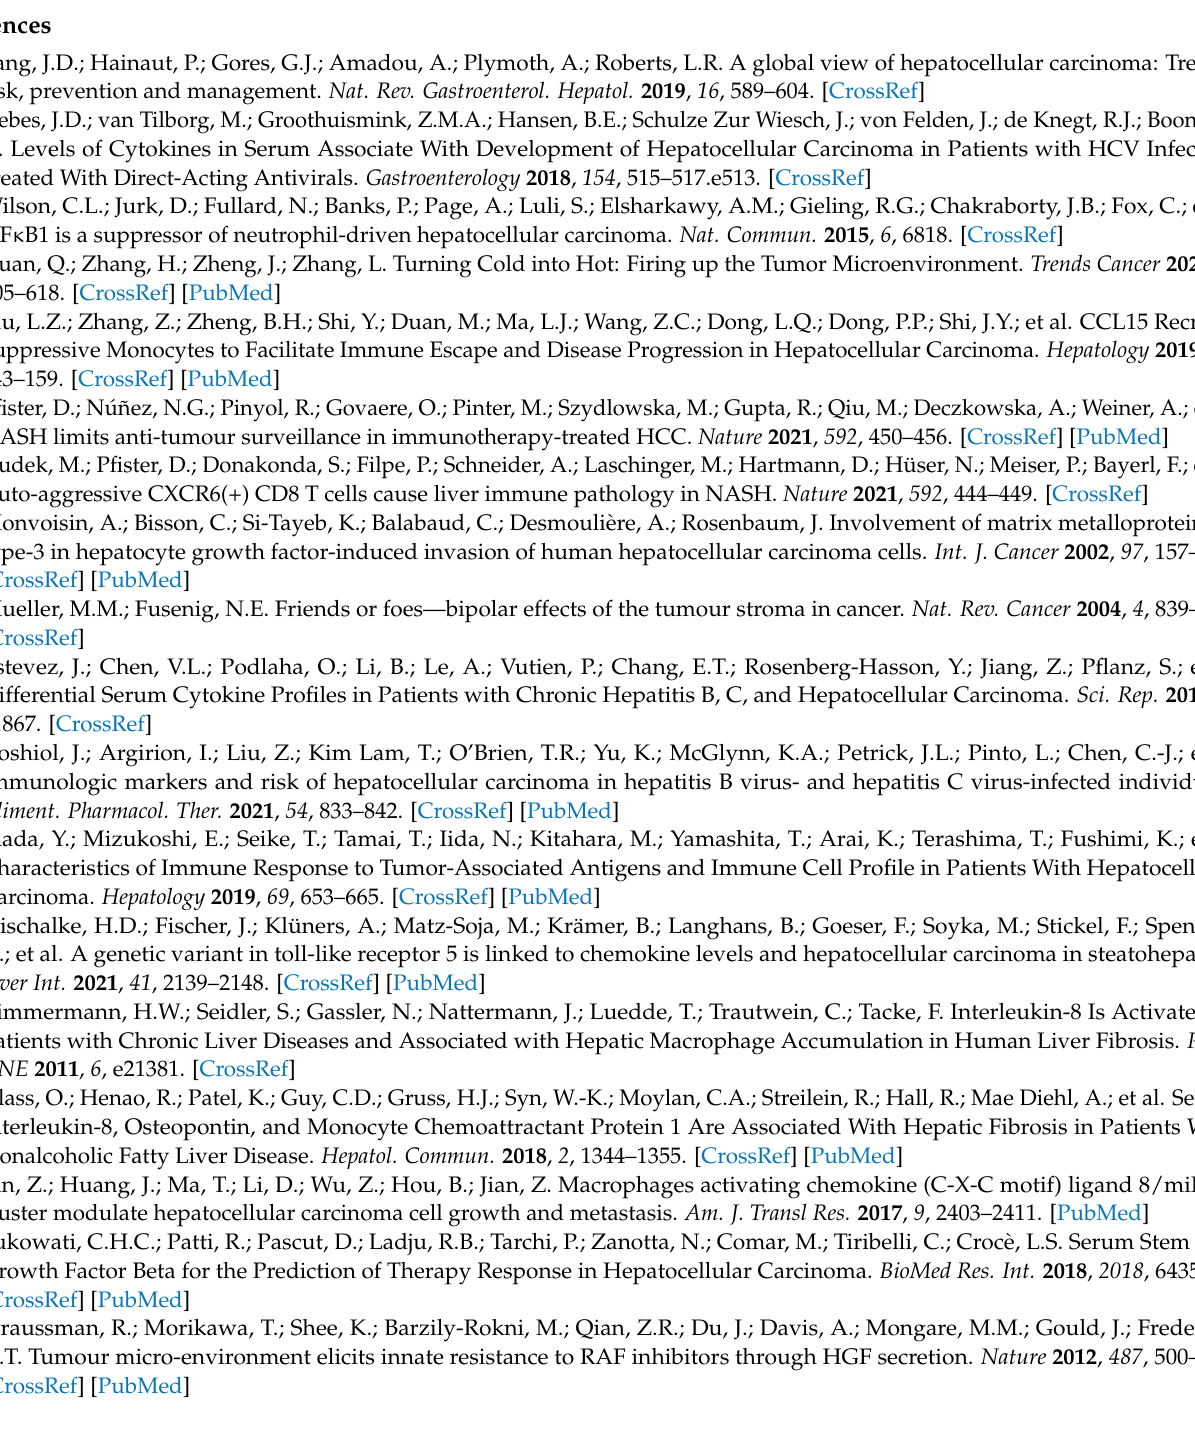
Abbreviations Limit of detection (LLOD), hepatitis B virus (HBV), hepatitis C virus (HCV), alcoholic liver disease (ALD), non-alcoholic fatty liver disease (NAFLD), hepatocellular carcinoma (HCC), interleukin (IL), chemokine (C-X-C motif) ligand (CXCL), chemokine (C-C motif) ligand (CCL), matrixmetalloprotease (MMP), granulocyte colony stimulating factor (G-CSF), hepatocyte growth factor (HGF), platelet- derived growth factor (PDGF), stem cell factor (SCF), stem cell growth factor (SCGF), tumor necrosis factor (TNF), interferon (IFN), macrophage migration inhibitory factor (MIF), leukemia inhibitory factor (LIF), vascular endothelial growth factor (VEGF), alpha-fetoprotein